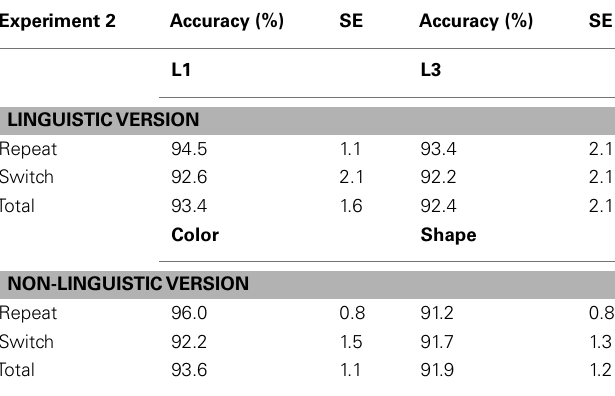
Table 3 |Accuracy (%) and SE in the linguistic and non-linguistic versions of the task-switching broken for trial types for the Experiment